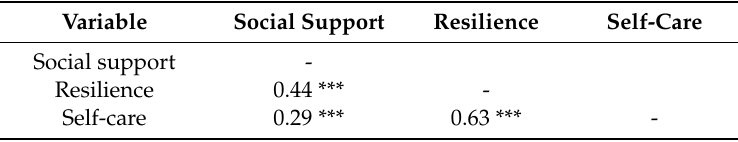
Table 3. Correlations among the